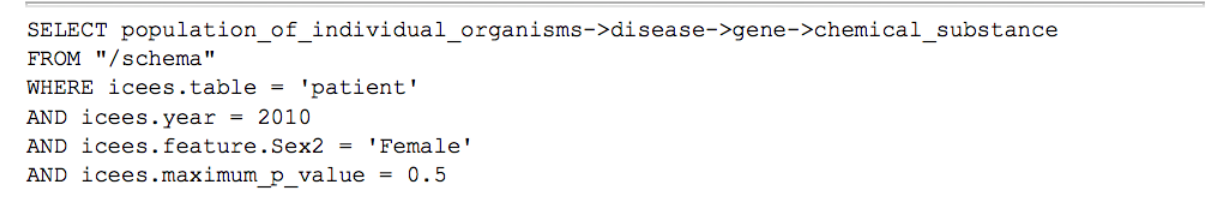
Figure 2. TranQL query for use case